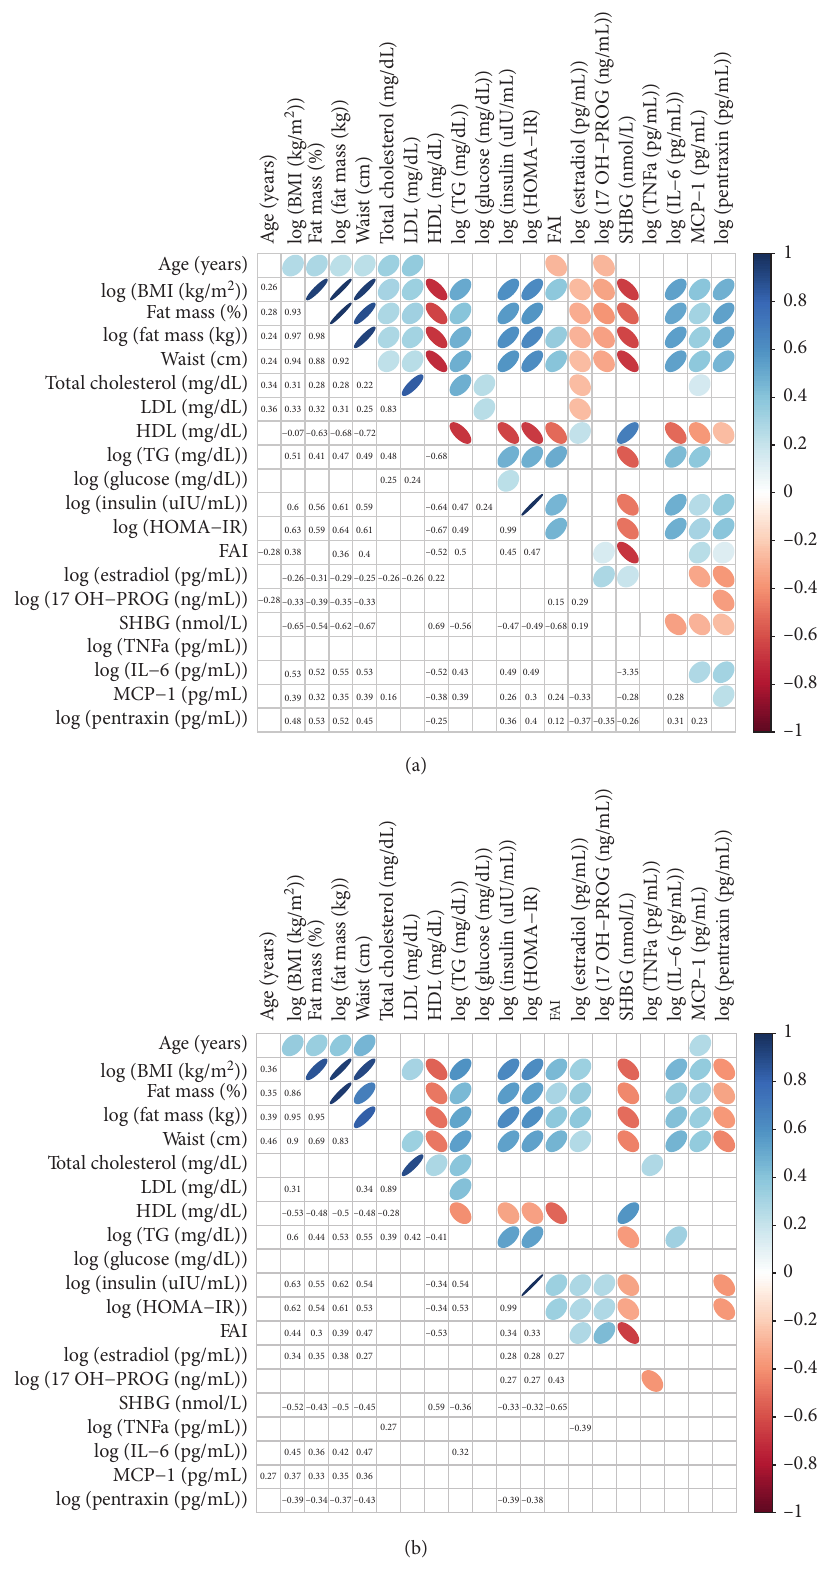
Figure 2: Correlogram of analyzed variables in groups with and without